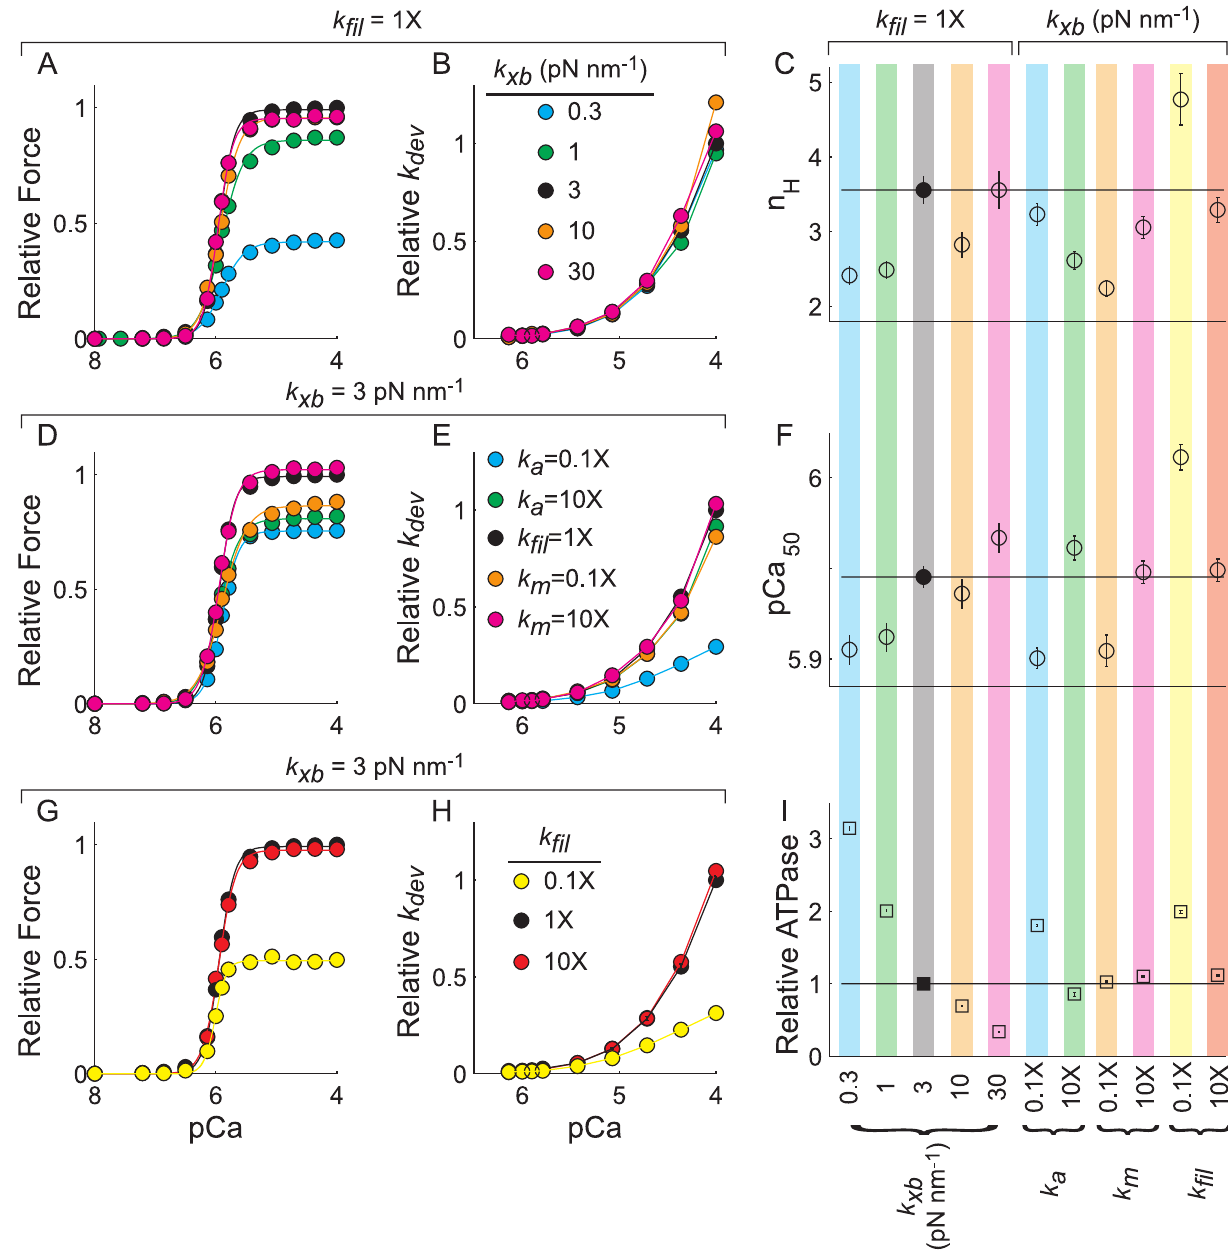
Figure 5. Mechanical properties of the myofilament lattice influence cooperative force production and maximal XB turnover. Simulation results for steady-state magnitude and rate of force development ( k dev ) are plotted against pCa as (A–B) XB stiffness ( k xb ) varied, (D–E) thick or thin filament stiffness ( k m or k a ) varied independently, or (G–H) both filament stiffness values ( k fil ) varied simultaneously. Parameter values from 3 parameter Hill fits to these force-pCa relationships demonstrate that mechanical properties ( i.e. stiffness) of they myofilament lattice can influence cooperativity ( n H ; panel C) and Ca 2 + sensitivity ( pCa 50 ; panel F) of force production. The rates of XB cycling or turnover directly correlate with ATPase values (I). All relative values were normalized to results for the standard parameter values (solid black circle) of k xb =3 pN nm 2 1 , k fil = k m = k a =1X, RU span =9 actins, and all possible forms of cooperativity were implemented for all simulations. Symbols represent mean 6 SE in all panels except C and F, and error bars reside within the symbol when not visible. Symbols in panels C and D depict predicted parameter values with error bars representing 95% confidence intervals.